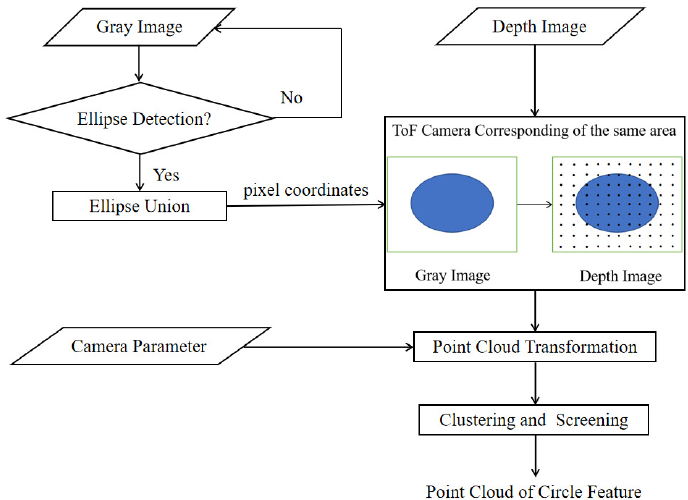
Figure 7. The flowchart of circle feature point cloud extraction.